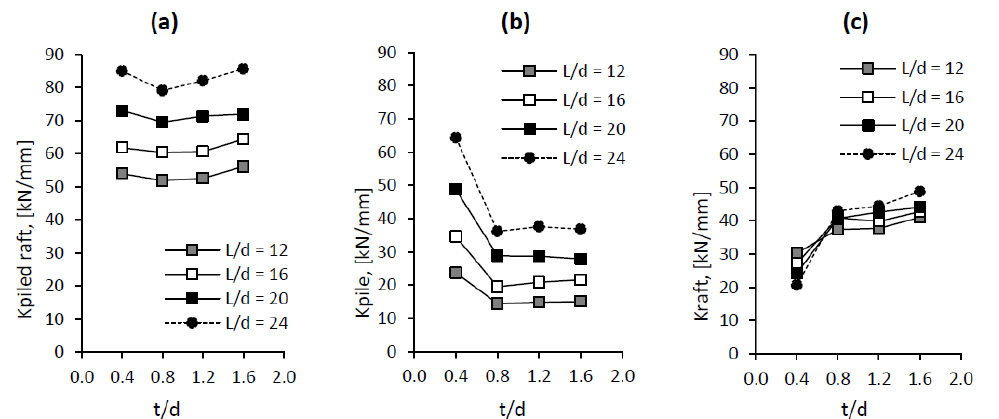
Figure 25. Effect of t/d ratio on piled raft, pile and raft responses